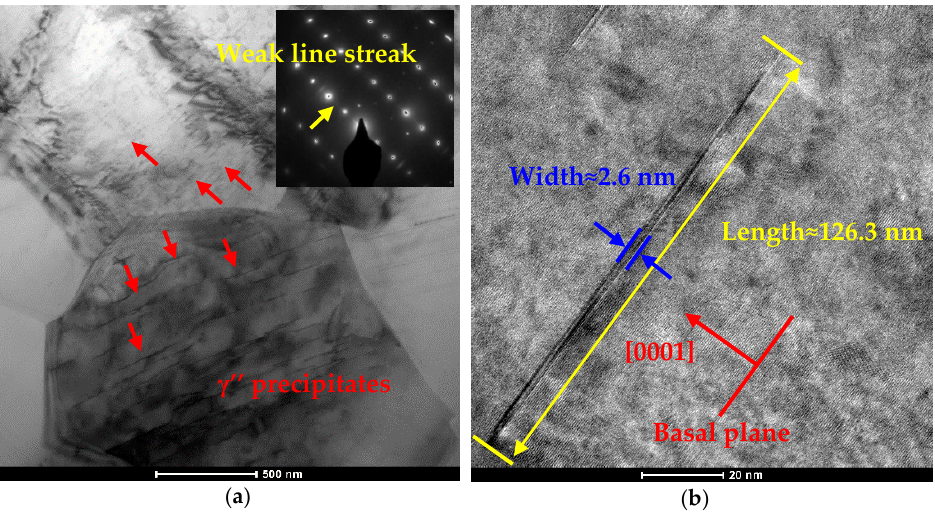
Figure 7. TEM images of T6 peak aged Mg-10Y-6Gd-1.5Zn-0.5Zr alloy. ( a ) Acicular γ ’’ precipitates formed within α -Mg grains; ( b ) High resolution (HR) TEM image of an acicular γ ’’ precipitate.